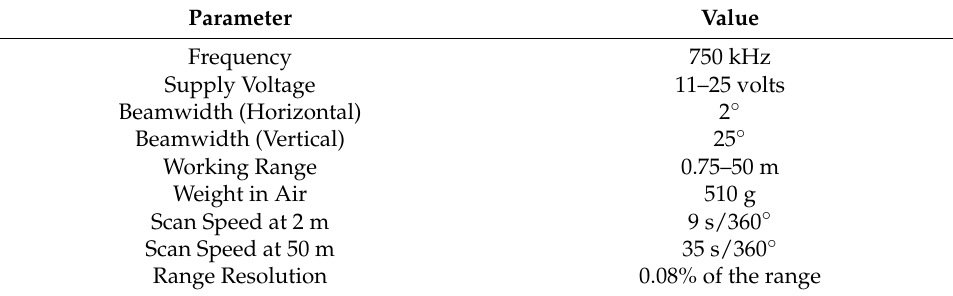
Figure 4. OERC tow tank of Memorial University of Newfoundland.